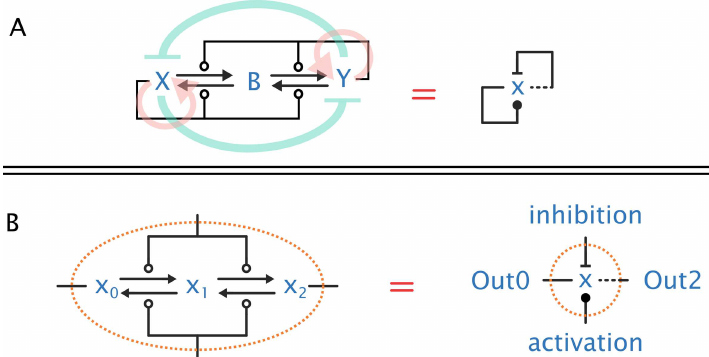
Fig 2. AM and network notation. (A) We recast the AM algorithmof Fig 1 as a wiring diagram.Left: the four reactionarrows correspond to the four state changesin Fig 1 (the hollowcircle stands for a catalytic reaction). The system presents two active states (X and Y) that are antagonist: X activates itself and inhibits Y, and Y activates itself and inhibitsX. Backgroundarrows indicatethe generatedfeedbacks loops: red arrows representthe pure positive feedbackloops and green ones represent the antagonistic double-negative, thus also positive, feedbackloop. Right: a condensedrepresentation of the same network accordingto the abbreviation explainedin (B). The condensedgraph shows that x activates itself (solid line indicatesX’s actions) and inhibits itself (dashedline indicatesY’s actions). (B) Notationfor condensedinfluencenetworks. A node X (right diagram)representsthree species (x 0 , x 1 , x 2 ) and four reactions(left diagram). A node X influences other nodeswhen it is in either of its extremal states: 0 state (Out0—solid outgoingedge) or 2 state (Out2—dashed outgoingedge). A node can be activated (ball-endedge) or inhibited(bar-endedge) by other nodes, the reactions of which drive the node betweenits various states. Note how the collapsednotation in (B) collapsesthe network (A, left) into the network (A, right). In the sequel, we mostly draw collapsednetworks, which can be systematically